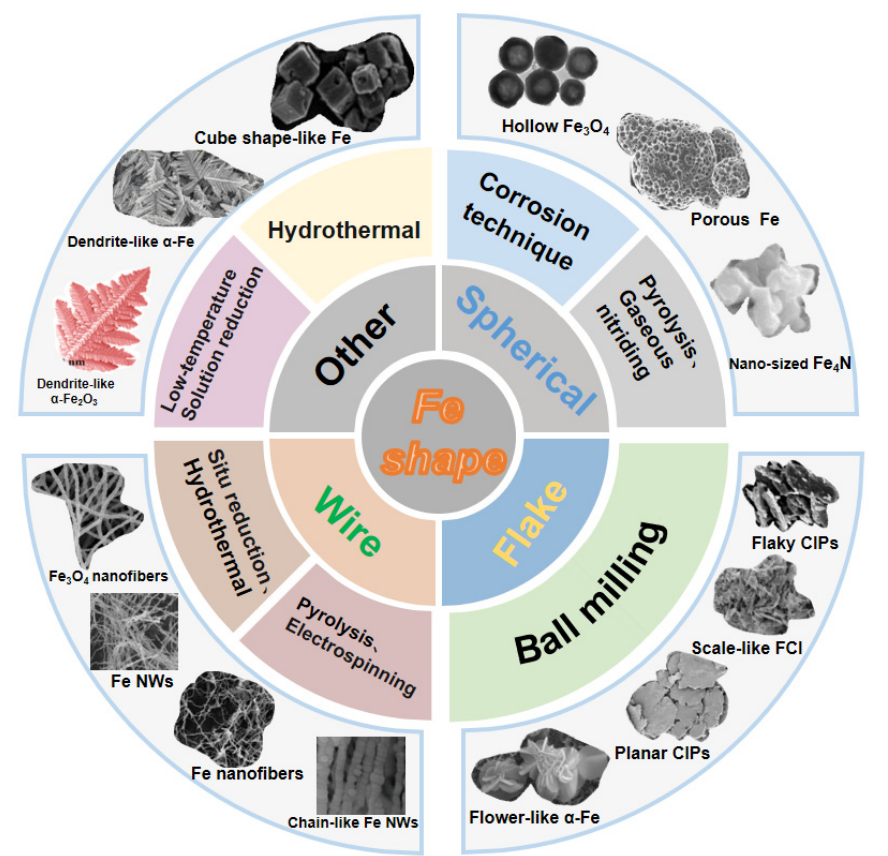
Figure 2. Classification and preparation of partially recent representatively different forms of Fe.